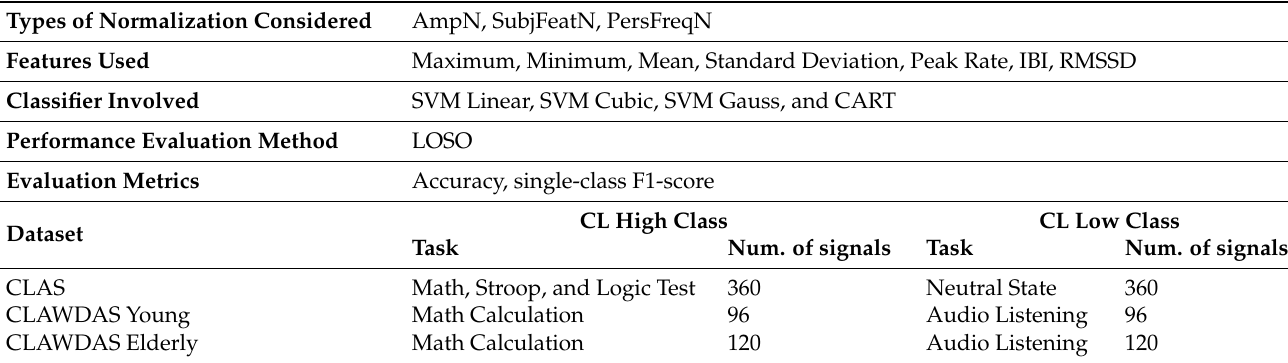
Figure 5. Pre-processing and feature extraction pipeline applied to the signals of the two datasets. The operations performed change according to the experiment considered: Amplitude Normaliza- tion (AmpN), amplitude normalization followed by a Subject Feature Normalization (SubjFeatN), and amplitude normalization followed by the Personalized Normalization based on resting state heartbeat (PersFreqN). Table 3. Summary of the classification